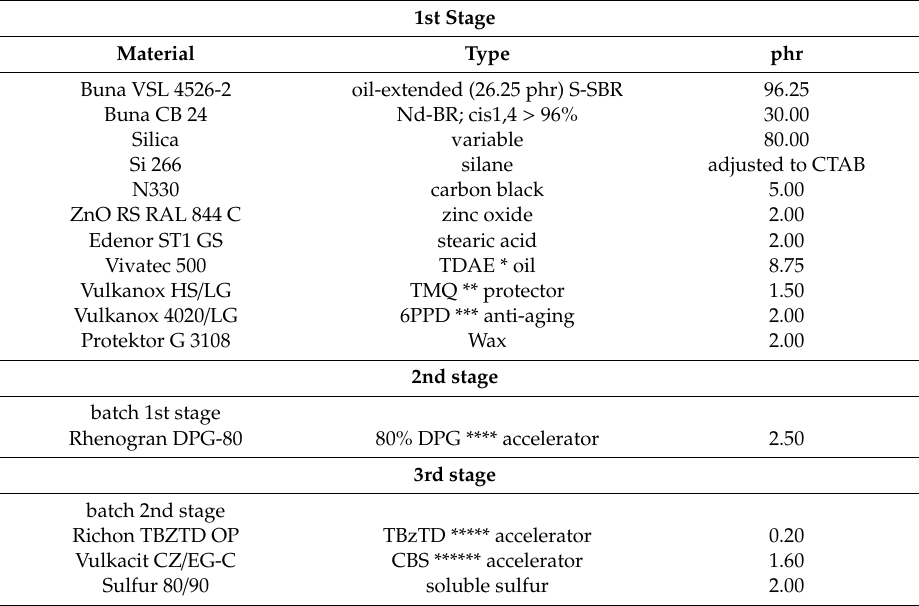
Table 2. Green tire formulation filled with 80 phr of silica (GT80).